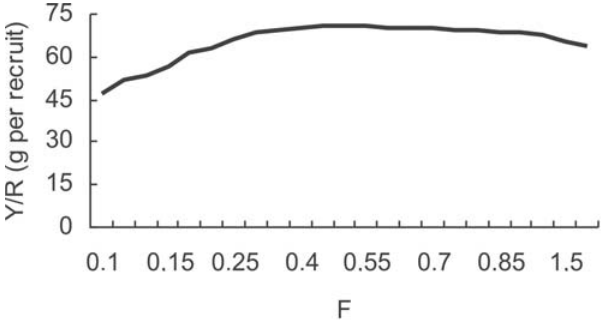
Fig. 8 . Beverton and Holt’s yield-per-recruit curve for L.